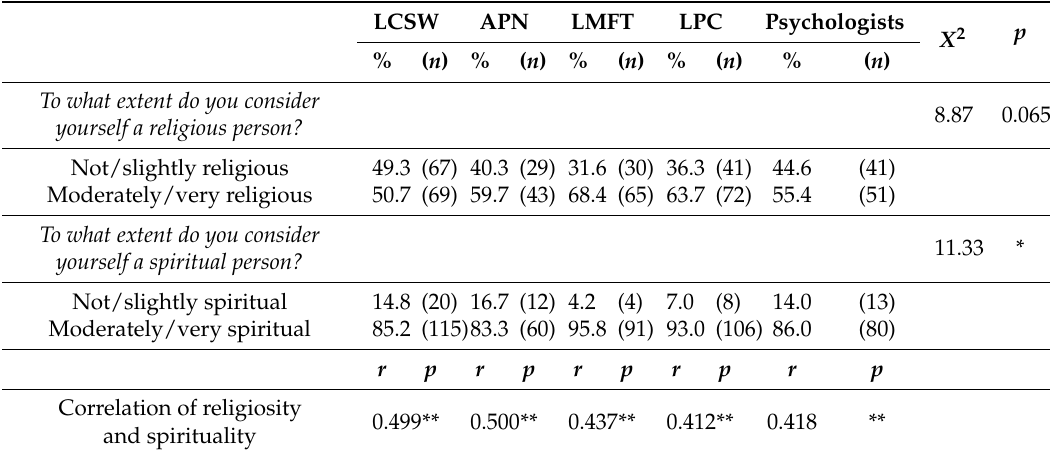
Table 3. Spirituality and Religiosity among Helping Professions in